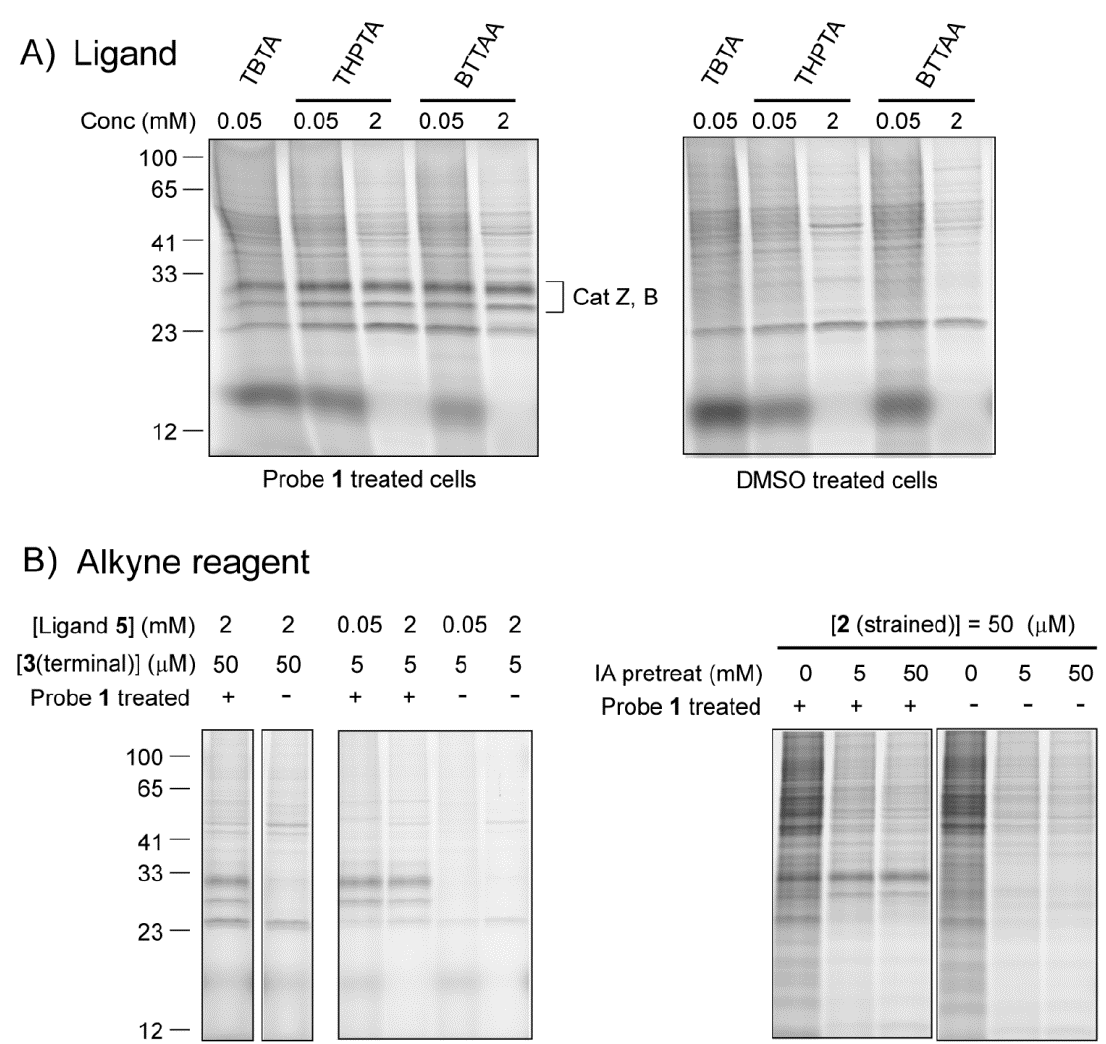
Figure 3. ( A ) Comparison of the three different Cu(I) ligands for click chemistry. Cells were treated for 1 h with 5 μ M of probe 1 , washed and lysed with 1% NP-40 in 100 mM sodium phosphate pH 7.4. Lysates (diluted to 1 mg/mL total protein, 0.1% NP-40 final concentration) were incubated for 1 h with 1 mM CuSO , 1 mM sodium ascorbate, 50 μ M 4 or 2 mM ligand and 50 μ M of the terminal alkyne tag 3 . ( B ) Comparison of Cu(I)-catalyzed and strain promoted click chemistry in lysates. Samples were treated similar as under (a) with THPTA as a ligand, but with different concentrations of the alkyne reagent. For strain-promoted click chemistry, only reagent 2 was added. Right panel: samples were pre-treated for 30 min with the indicated concentration of iodoacetamide (IA), then treated with strained alkyne 2 (5 μ